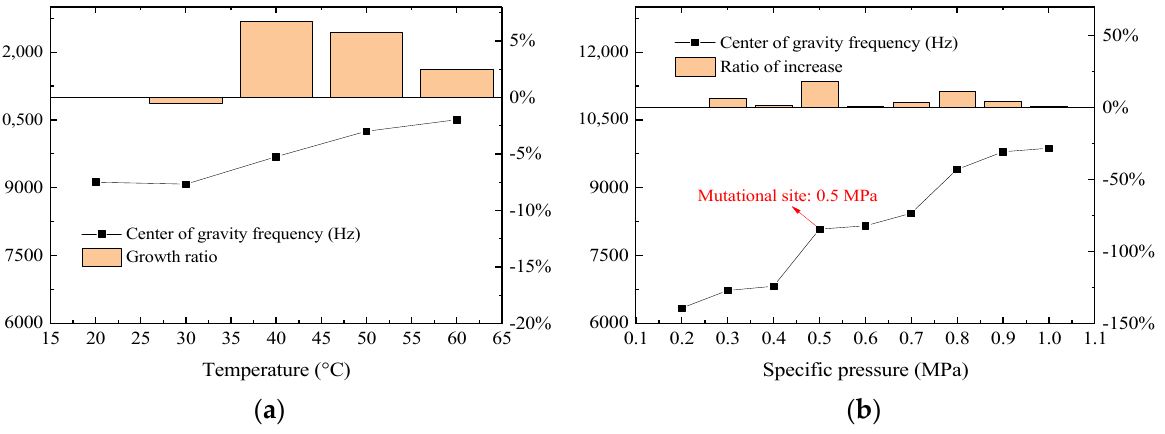
Figure 21. Effect of the specific pressure and temperature on the center of gravity frequency and growth ratio. ( a ) Specific pressure, ( b ) temperature.